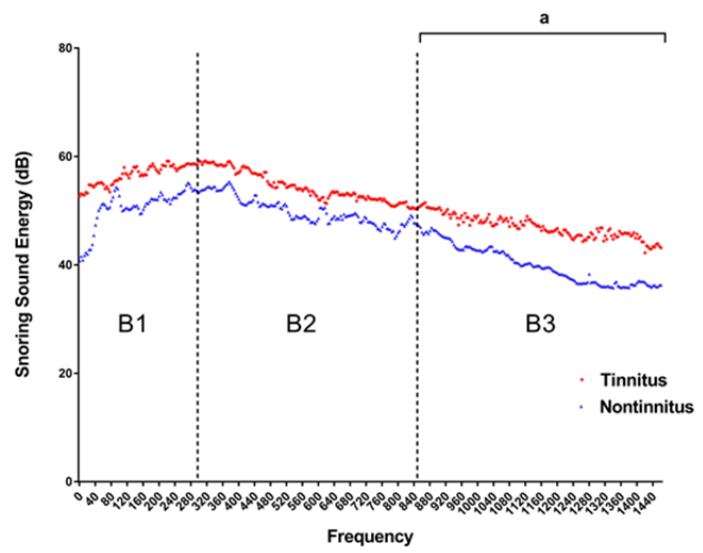
Figure 4. Comparisons of the intra-ear canal snoring sound energy (SSE) between tinnitus and non-tinnitus groups (n = 50). The SEE of B3 frequency domain was significantly higher in the tinnitus group than in the non-tinnitus group ( p = 0.04). (Frequency domain, B1: 4 – 300 Hz; B2: 301 – 850 Hz; B3: 851 – 1500 Hz.). a Two-tailed p value < 0.05 (Mann – Whitney U test). Table 3. Comparisons of snoring sound energy between tinnitus and non-tinnitus group.